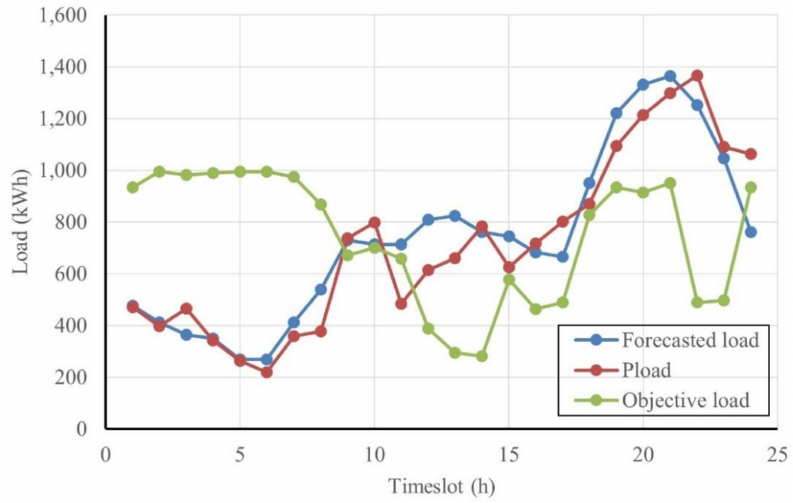
Mathematics 2021 , 9 , x FOR PEER REVIEW Figure 5. Hourly residential load before and after shifting using TOU-PSO.